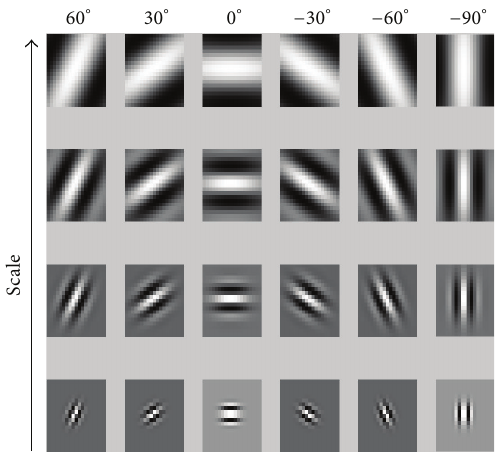
Figure 11: Example of Gabor filters with four scales and six directions.